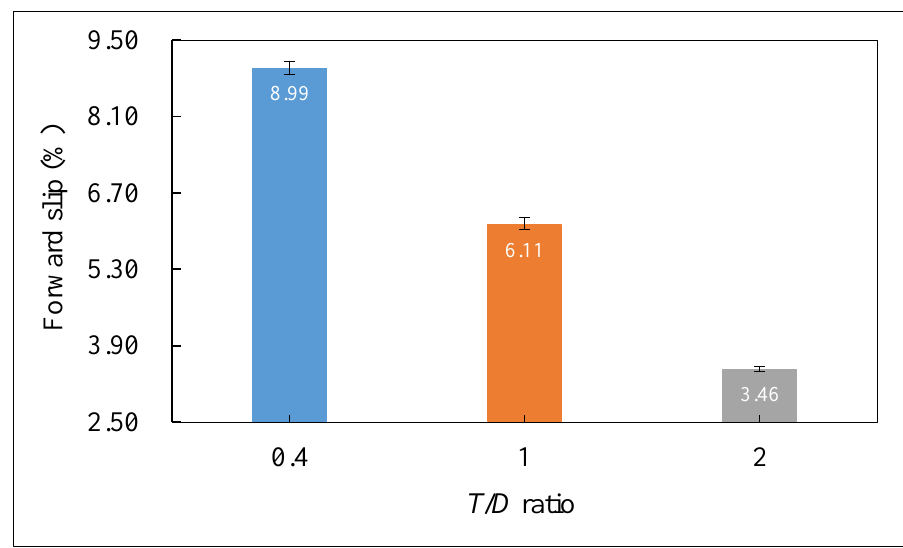
Figure 12. Tendency of forward slip with T / D ratio for the rolling phase with thicker thickness.